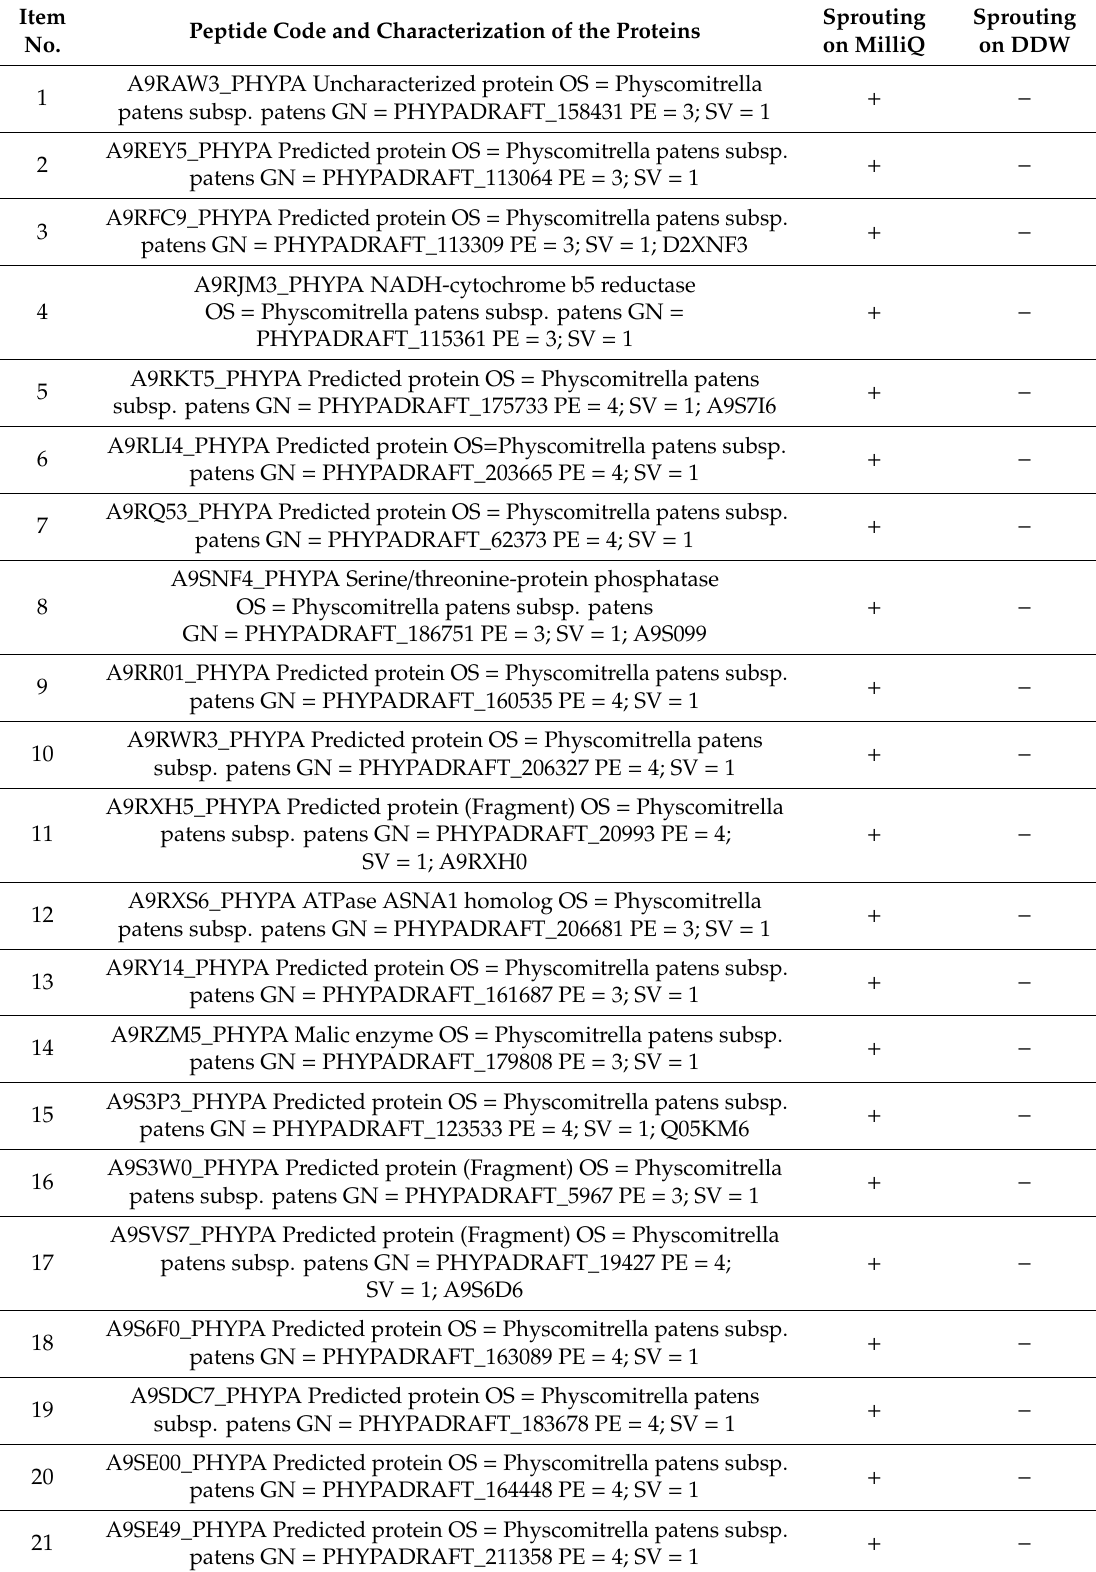
Table 4. Changes in the moss peptidom during the sprouting on DDW (peptide names are given according to international nomenclature [36]). “ + ”—present; “ −